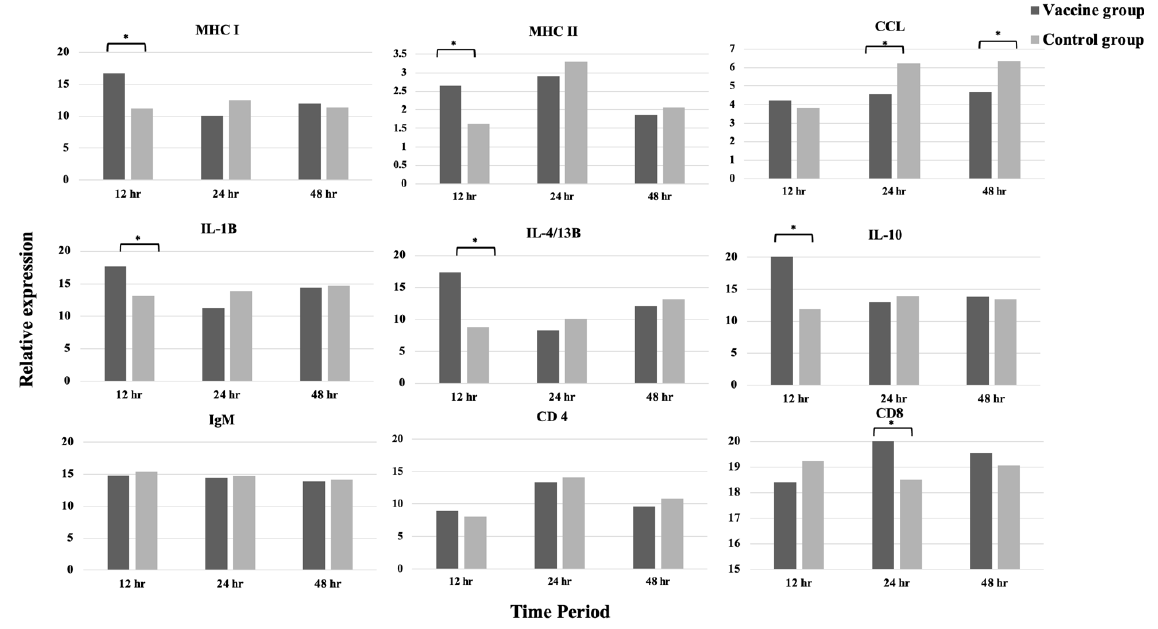
Figure 4. Expression profiles of immune-related genes in challenged vaccinated survivors and challenged control survivors at 12, 24, and 48 h post-challenge (* p <